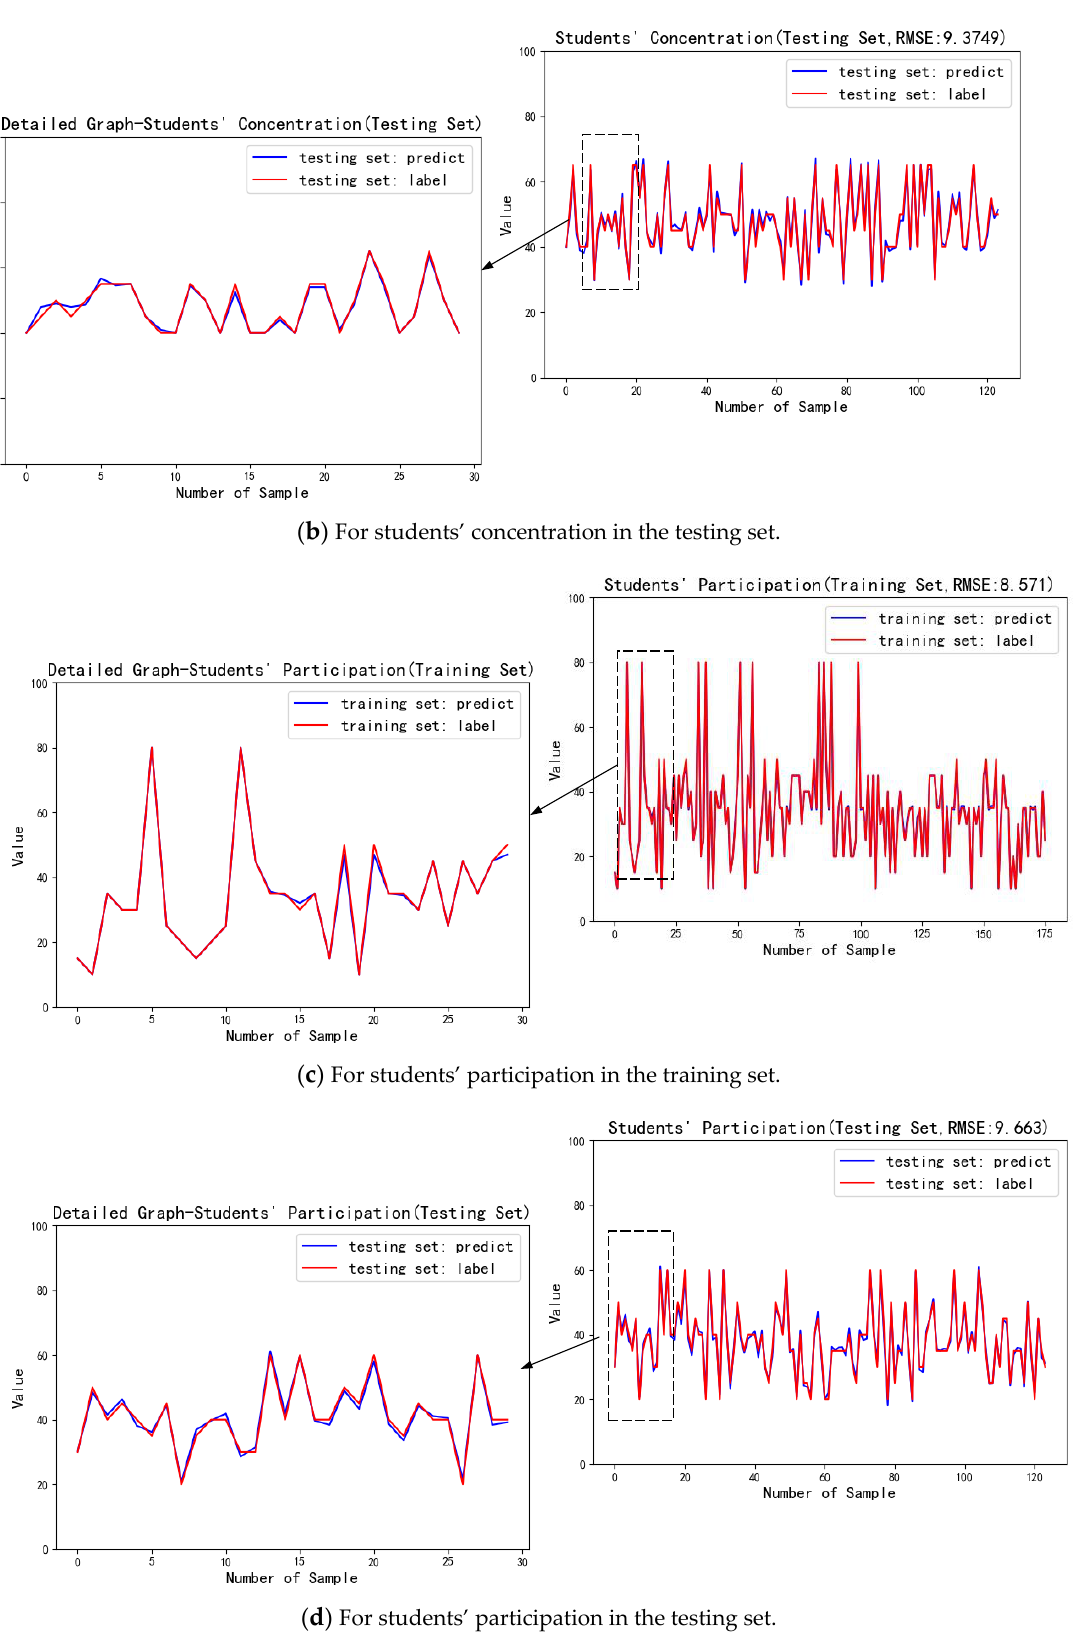
Figure 11. Performance analysis for score indicators evaluated by the ensemble learning model.